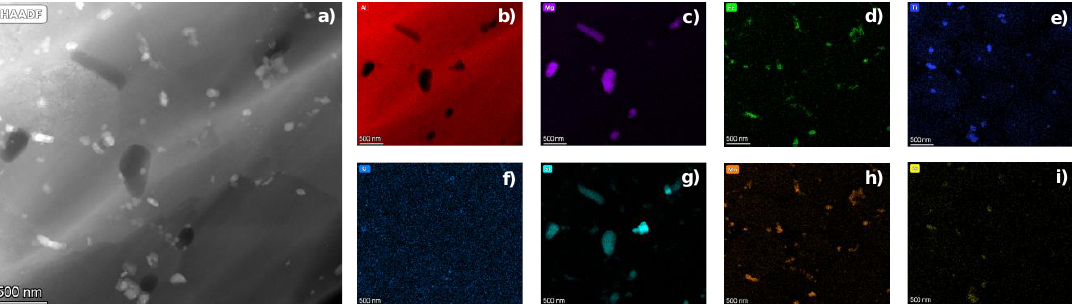
Figure 7. ( a – i ) . Microstructural analysis in TEM ( a ) High-angle annular dark-field scanning transmission electron microscope (HAADF-STEM) overview micrograph of the fine grained, equiaxed α -Al grain area in the as-built part; ( b – i ) corresponding energy-dispersive X-ray spectroscopy (EDX) maps for ( b ): Al, ( c ): Mg, ( d ): Fe, ( e ): Ti, ( f ): O, ( g ): Si, ( h ): Mn, ( i ): Zr.